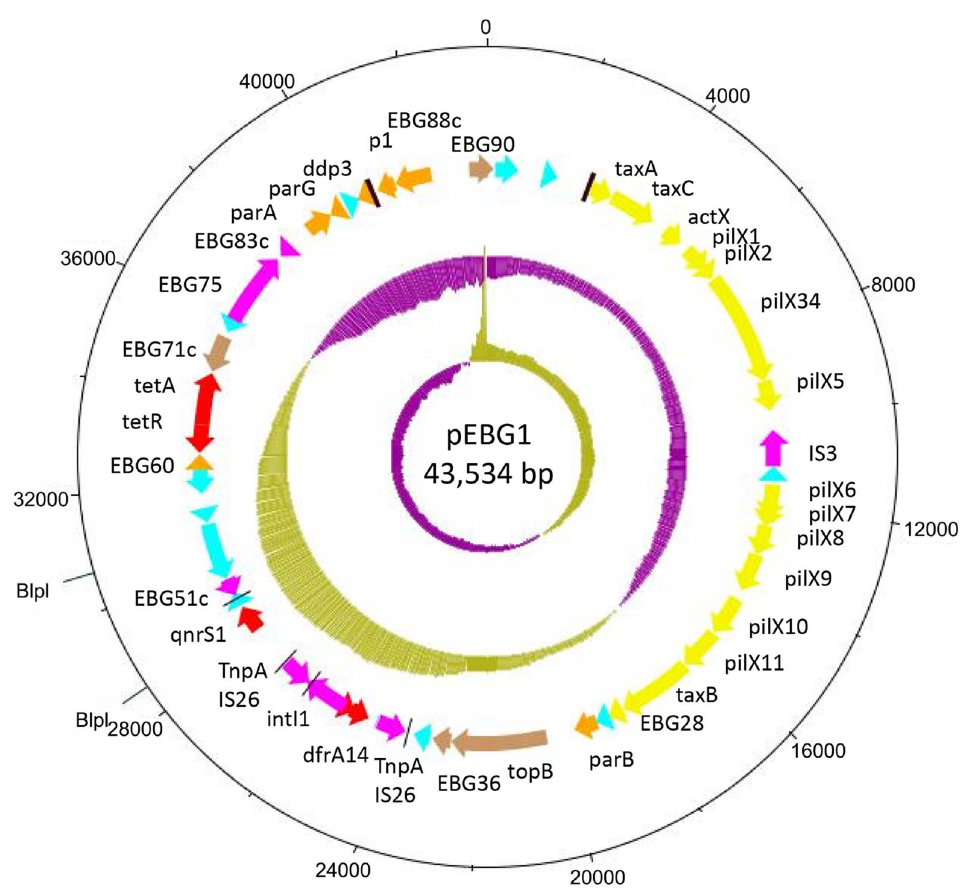
Figure 3. Circular map of pEBG1. and BlpI restriction sites conjugation genes are yellow and those that are predicted to encode proteins involved in DNA mobility or transposition are pink. Orange colored genes are involved in plasmid maintenance; other predicted open reading frames colored brown and hypothetical open-reading frames are colored light blue. Predicted OriT sites are marked as heavy dark brown lines. Thin black lines indicate the positions of IS 26 repeats.